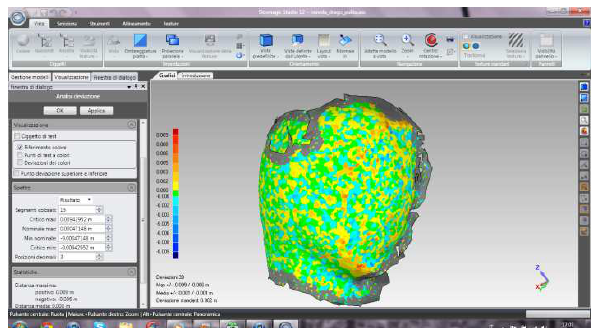
Figure 12. The deviations points-model (from the C 10 scans) for the head of St. George